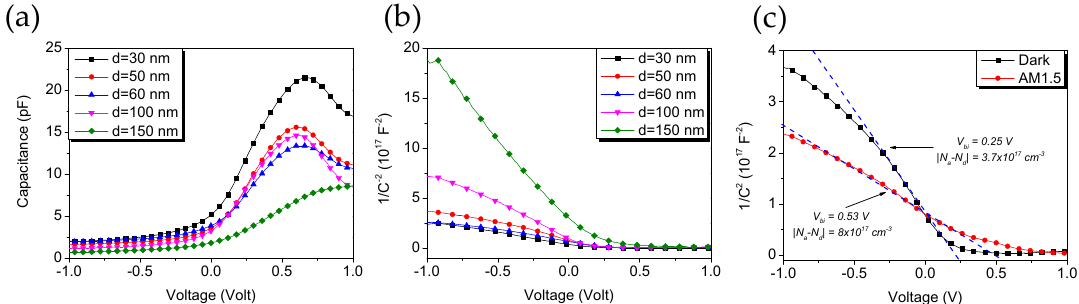
Figure 7. ( a ) Capacitance–voltage characteristics and ( b ) Mott–Schottky 1 / C 2 (V) plots of Si / GaN